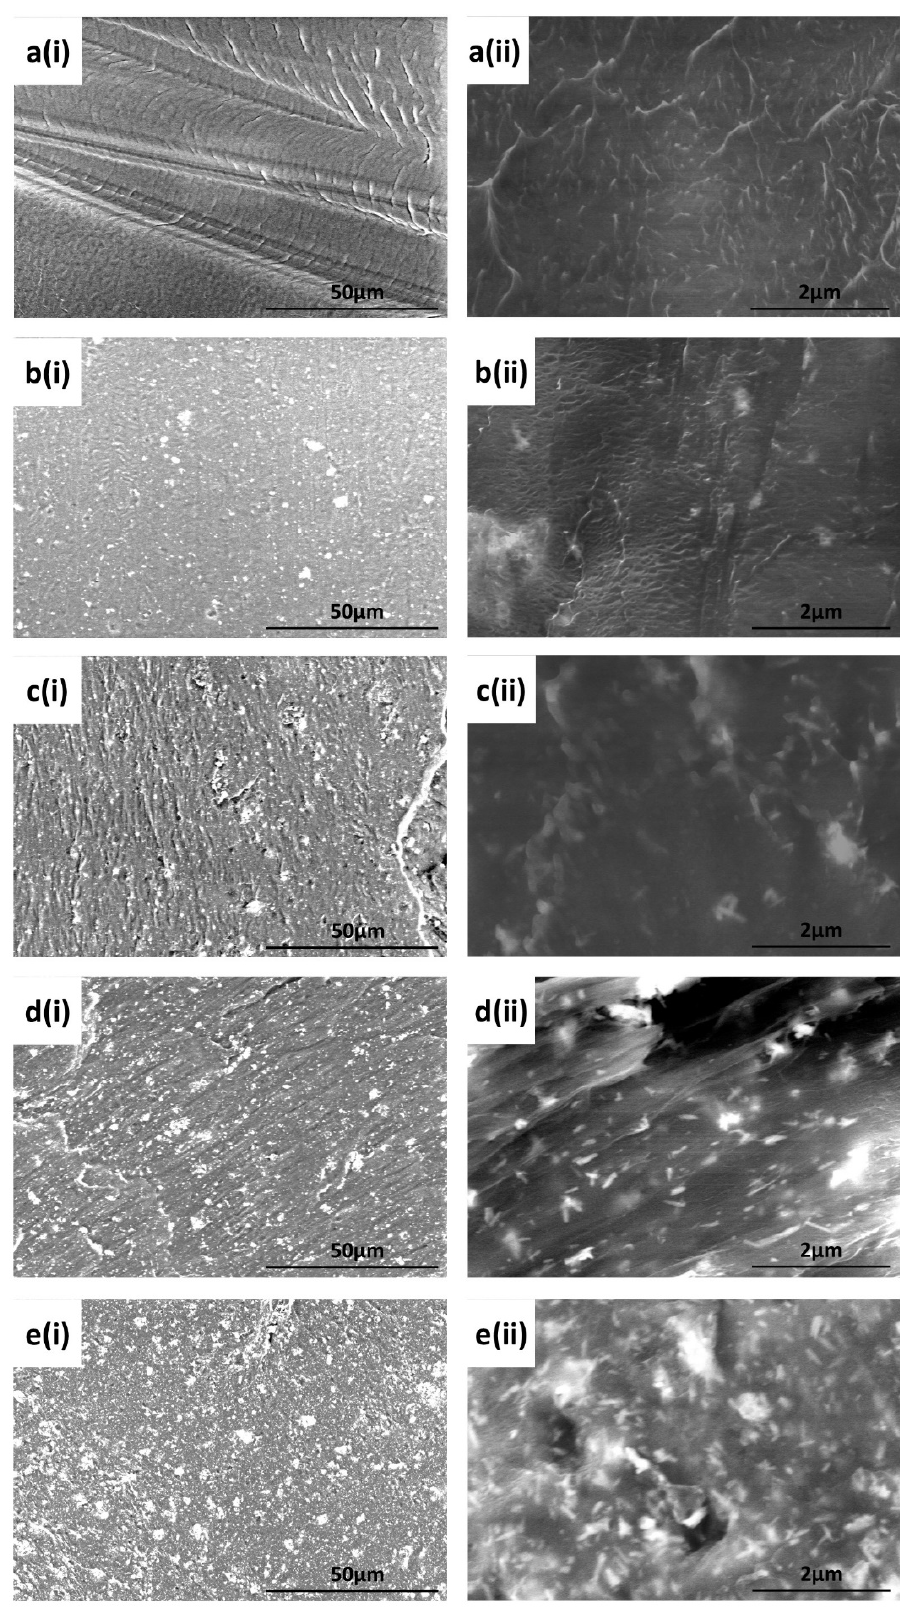
Figure 4. SEM images for ( a ) 0HA, ( b ) 5HA, ( c ) 10HA, ( d ) 20HA, and ( e ) 30HA. Here, set ( i ) and ( ii ) are recorded at 1 k and 20 k magnification.